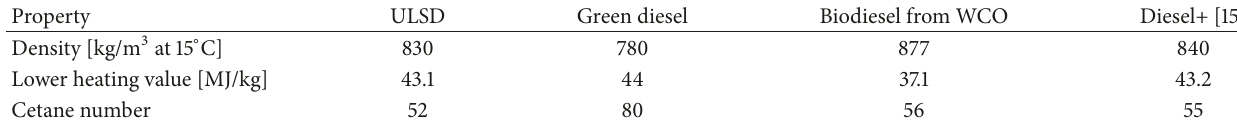
Table 3: ULSD, green diesel, and biodiesel from WCO and diesel+ properties.